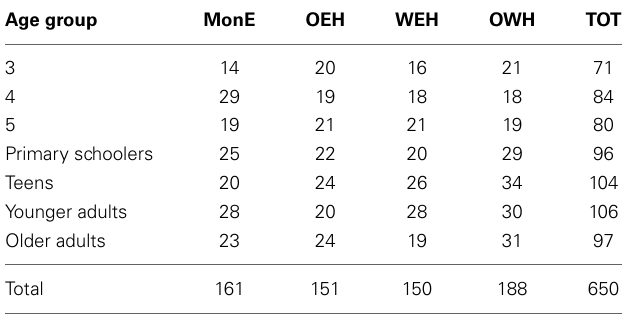
Table 1 | Participants, card sorting tasks.